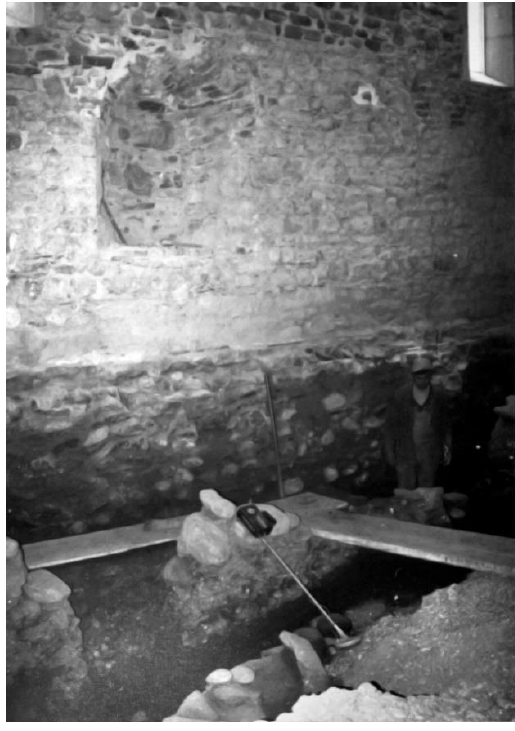
Figure 12. A niche in the southern wall of the hall. Interior. Photo: The Maribor Regional Office of the IPCHS, Fond Maribor—Sinagoga.